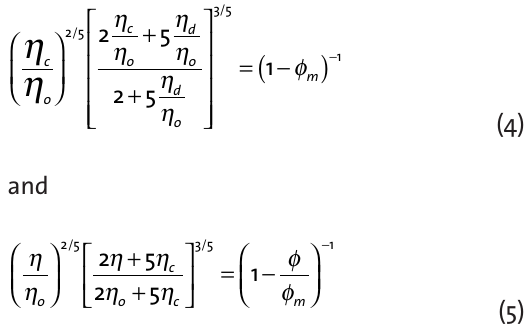
Figure 1 (left): Photo- micrographs of milk fat in skimmed milk emulsions at different concentrations (magnification x200). Figure 2 (right): Evolution of particle size distribution with increase in fat content in milk